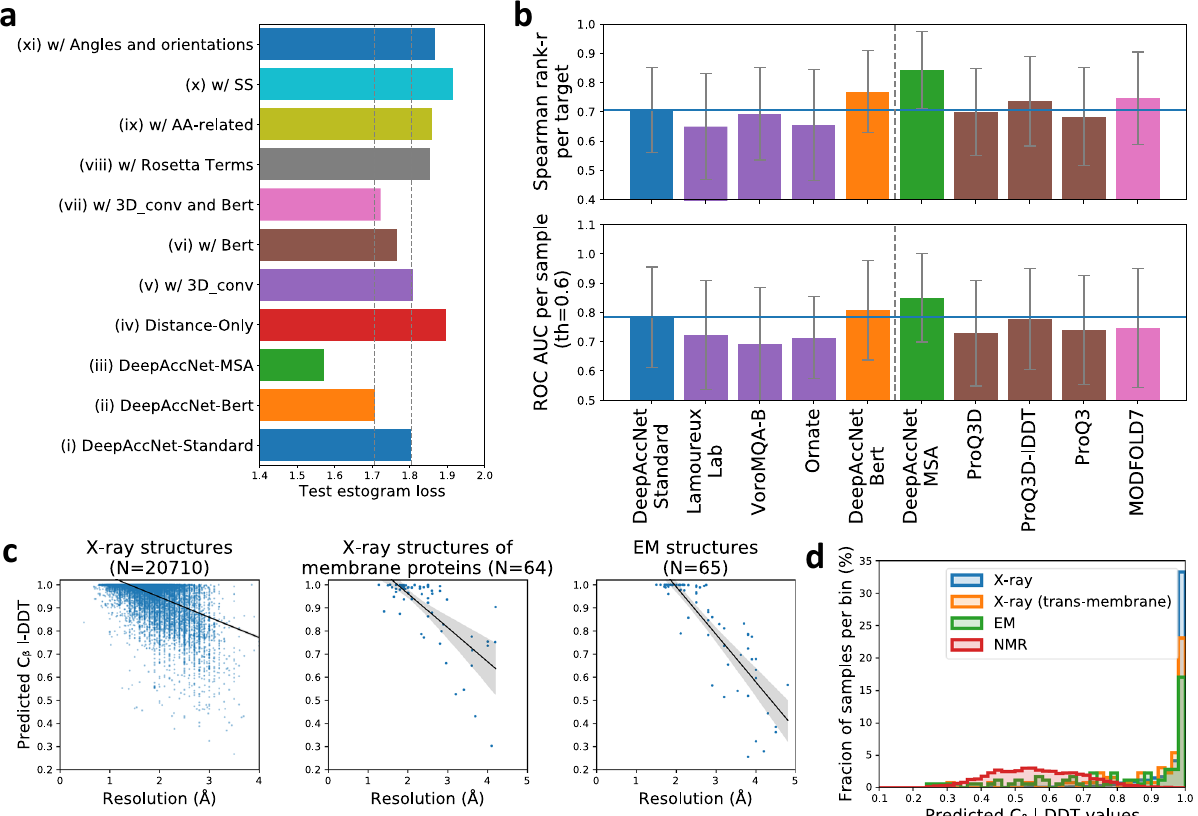
Fig. 3 DeepAccNet performance. a Contribution of individual features to network performance; all models include the distance matrix features. Overall, the largest contribution is from the features generated by 3D convolutions on local environments, Bert embeddings, and MSA information. Estogram (cross- entropy) loss values averaged overall decoys for each test protein are shown as one data point. The gray dotted line shows the values from predictors (i) and (ii). b Comparison of the performance of single-model accuracy estimation (EMA) methods on CASP13 data. (top) Performance of global accuracy estimation measured by the mean of the Spearman correlation coef fi cient ( r -value) of predicted and actual global l-DDT scores per target protein. (bottom) Performance of local accuracy estimation measured by the mean of area under receiver operator characteristic (ROC) curve for predicting mis- modeled residues per sample (all-atom l-DDT < 0.6). The blue horizontal lines show the value of DeepAccNet-Standard. The methods to the left of the dotted line do not use coevolutionary information. Quasi-single EMA method is shown in pink. Error bars show standard deviation. c Predicted C β I-DDT by DeepAccNet-Standard correlates with resolution for X-ray structures (left; Spearman-r 0.48 with p -value < 0.0001), X-ray structures of transmembrane proteins (middle; Spearman-r 0.64 with p -value < 0.0001), and cryoEM structures (right; Spearman-r 0.87 with p -value < 0.0001). d X-ray structures have higher predicted C β I-DDT values by DeepAccNet-Standard than NMR